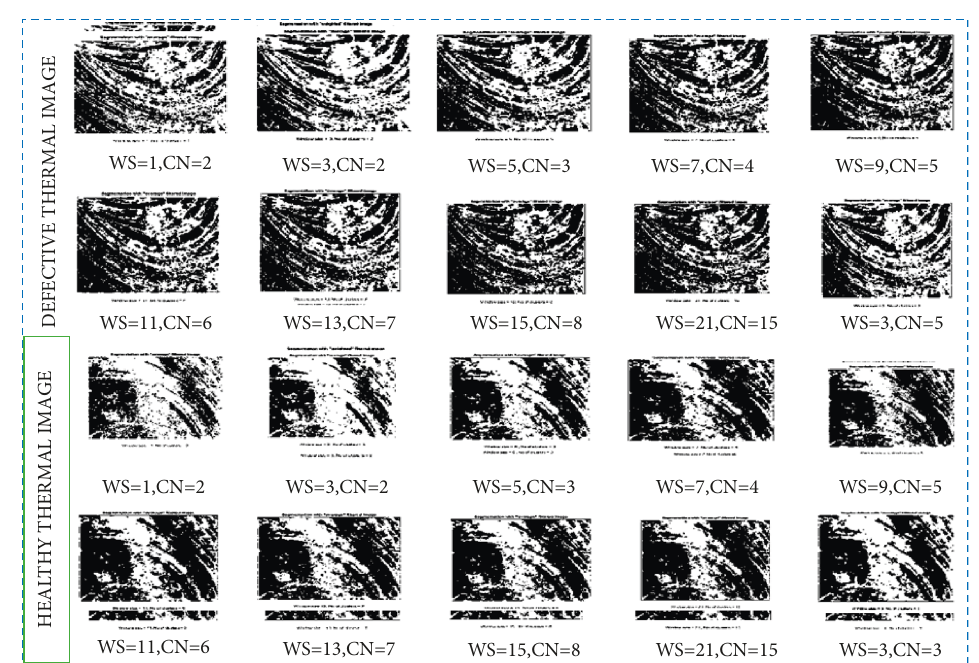
Figure 4: ARKFCM outputs using the weighted filter for defective and healthy thermal